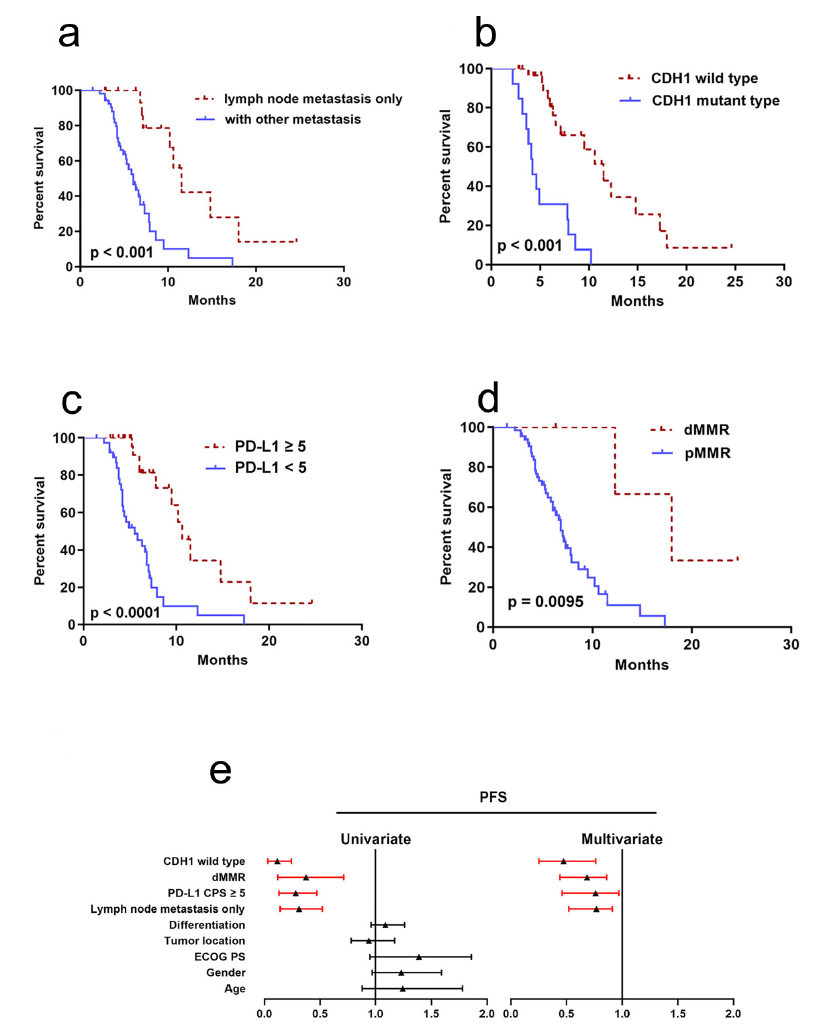
Figure 2. Clinicopathological and molecular factors to predict PFS. ( a ) Kaplan–Meier curve of lymph node metastasis ( p < 0.001); ( b ) Kaplan–Meier curve of CDH1 ( p < 0.001); ( c ) Kaplan–Meier curve of PD-L1 ( p < 0.001); ( d ) Kaplan–Meier curve of MMR ( p = 0.0095); ( e ) forest plot of univariate or multivariable Cox proportional hazard regression indicating the impact of different characteristics on